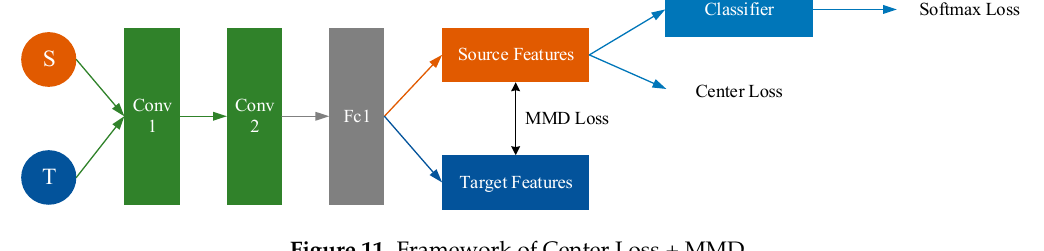
Figure 11. Framework of Center Loss + MMD. Table 8. The flow of the CMMD